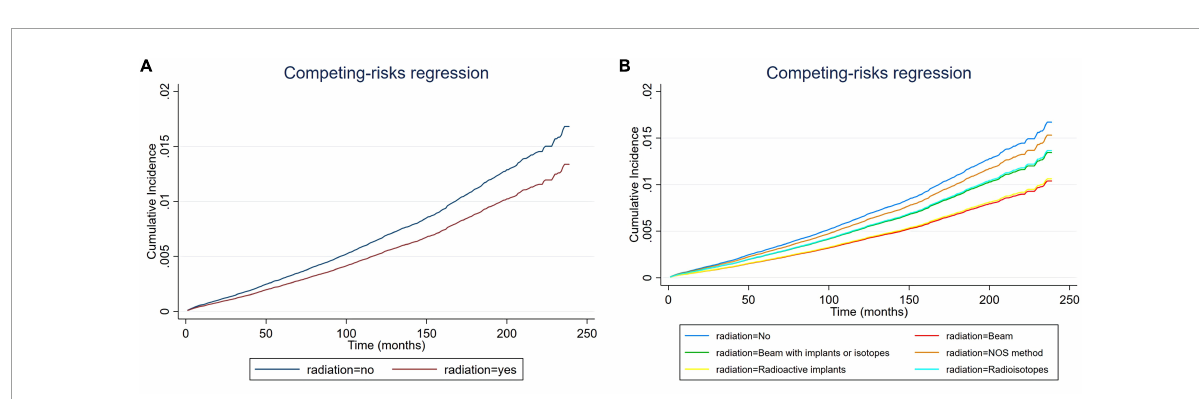
FIGURE4 Cumulative incidence rate of cardiac-specific death related to radiation therapy (RT) after propensity score matching (PSM) (the curves of “radioactive isotopes” and “beam with implants or isotopes” are overlapping and may not be drawn separately, as was the curves of “beam” and “radioactive implants”). The Y -axis of each panel shows the cumulative risk of cardiac-specific death and the X -axis shows the time since diagnosis in months. Each line represents the cumulative risk of cardiac-specific death in patients after receiving a treatment. (A) Cumulative risk of cardiac-specific death in patients with receiving and not receiving radiotherapy. (B) Cumulative risk of cardiacspecific death in patients with not receiving radiotherapy and receiving different modalities of radiotherapy.